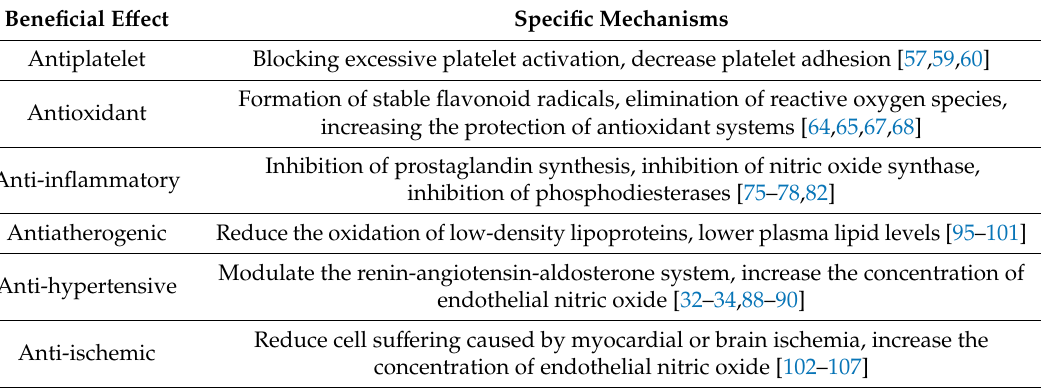
Table 3. Main beneficial e ff ects of flavonoids on health and mechanisms of